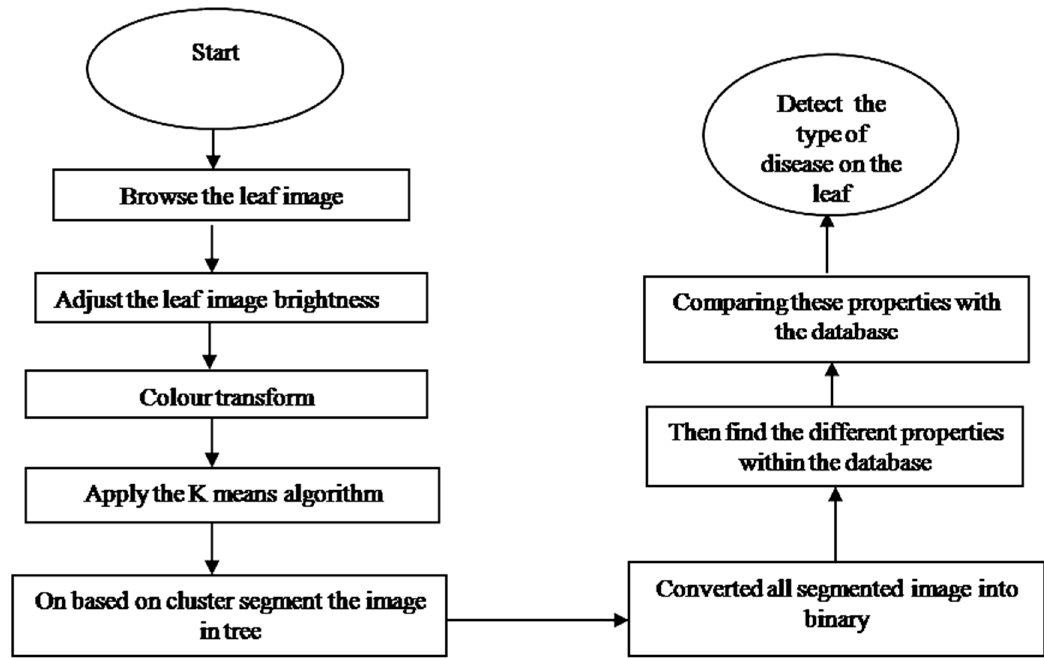
Figure 3. Flowchart of the leaf disease detection algorithm adapted from Khan et al. [52].